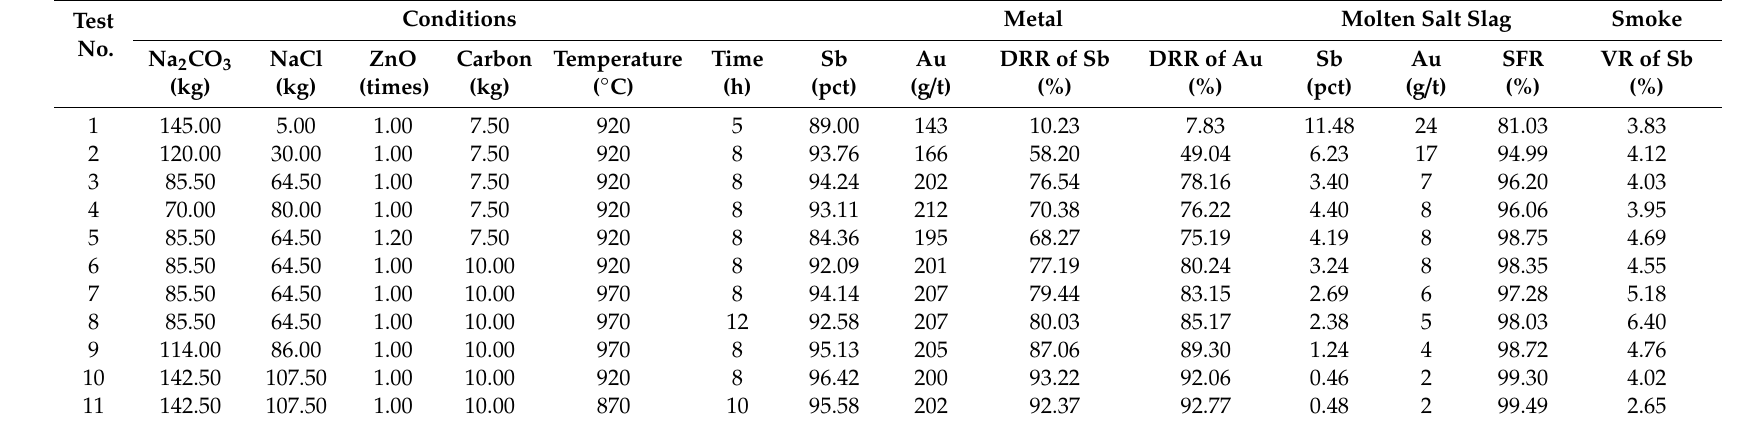
Table 4. Smelting results under di ff erent experimental conditions in kilogram-class pilot